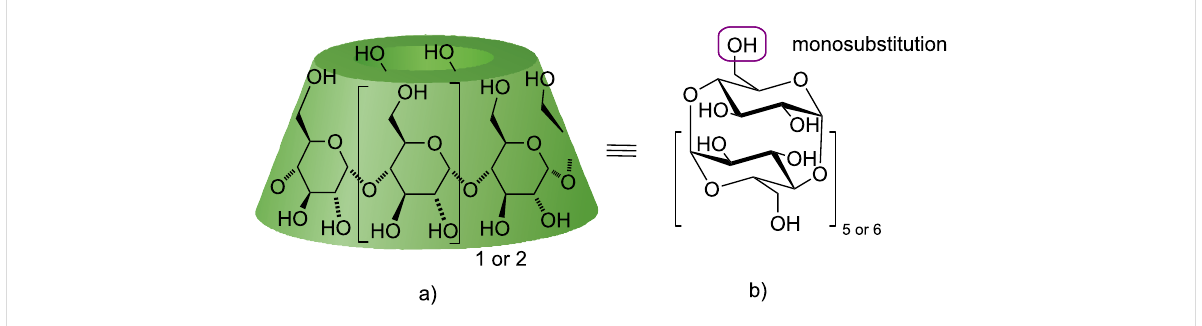
Figure 1: Schematic cone-shaped (a) and structure representations (b) of α -CD (six glucopyranoside units) and β -CD (seven glucopyranoside units).